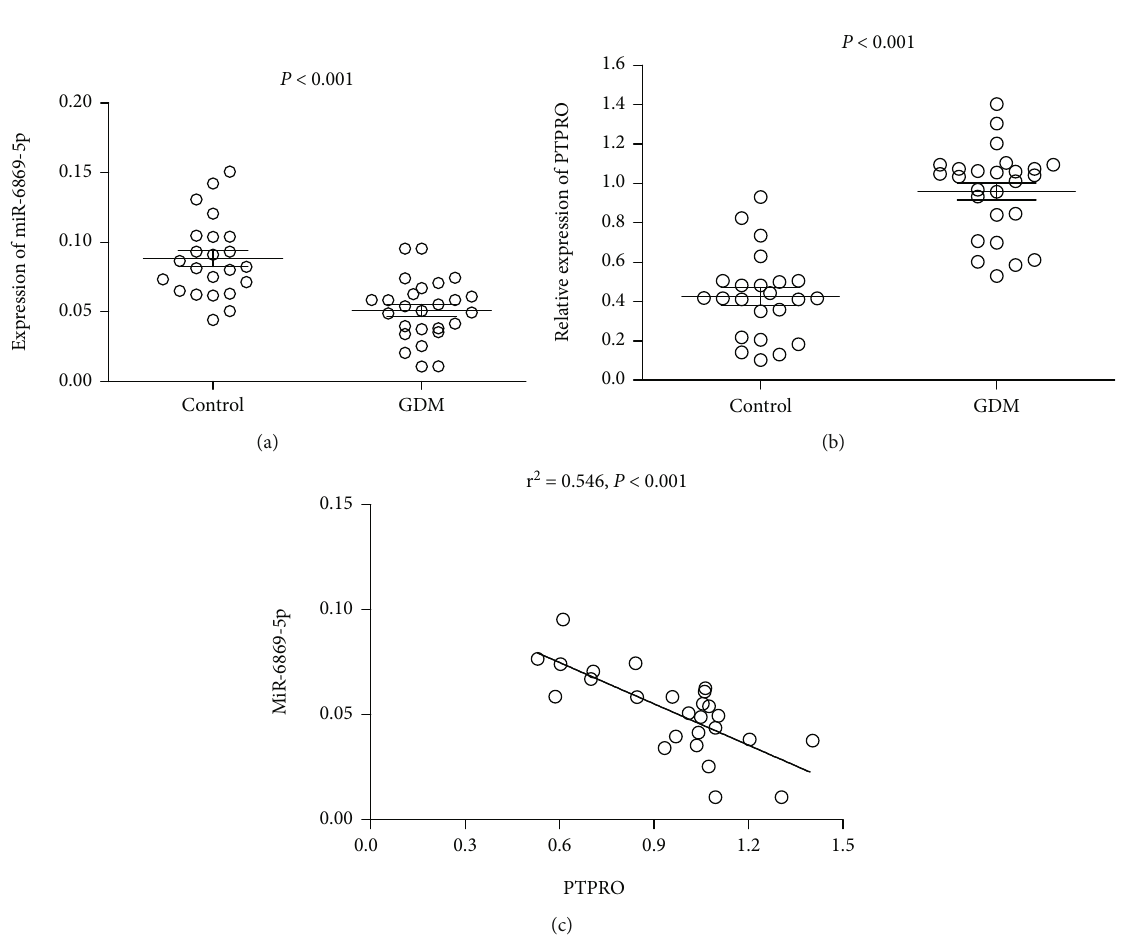
Figure 1: MiR-6869-5p and PTPRO expression in macrophages from placenta. (a) MiR-6869-5p expression in placenta derived macrophages (case/control: 26/23). (b) PTPRO expression in placenta derived macrophages (case/control: 26/23). (c) Association of miR-6869-5p with PTPRO in placenta derived macrophages of gestational diabetes mellitus (GDM) patients ( n = 26